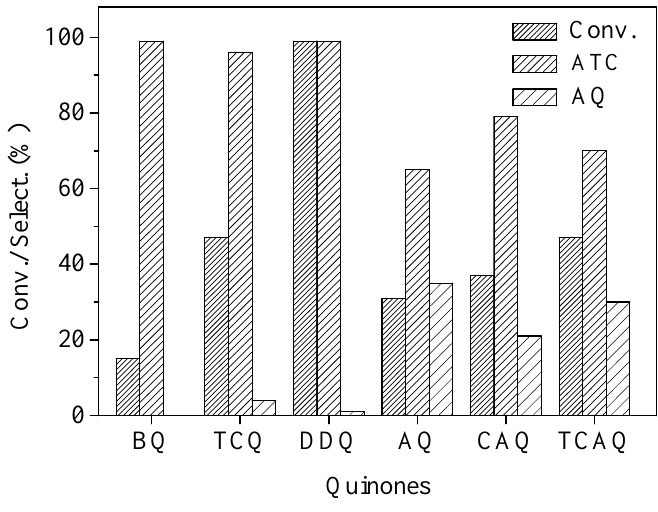
Figure 2 . The oxidative dehydrogenation of 9,10-dihydroanthracene with different a . quinones and NaNO 2